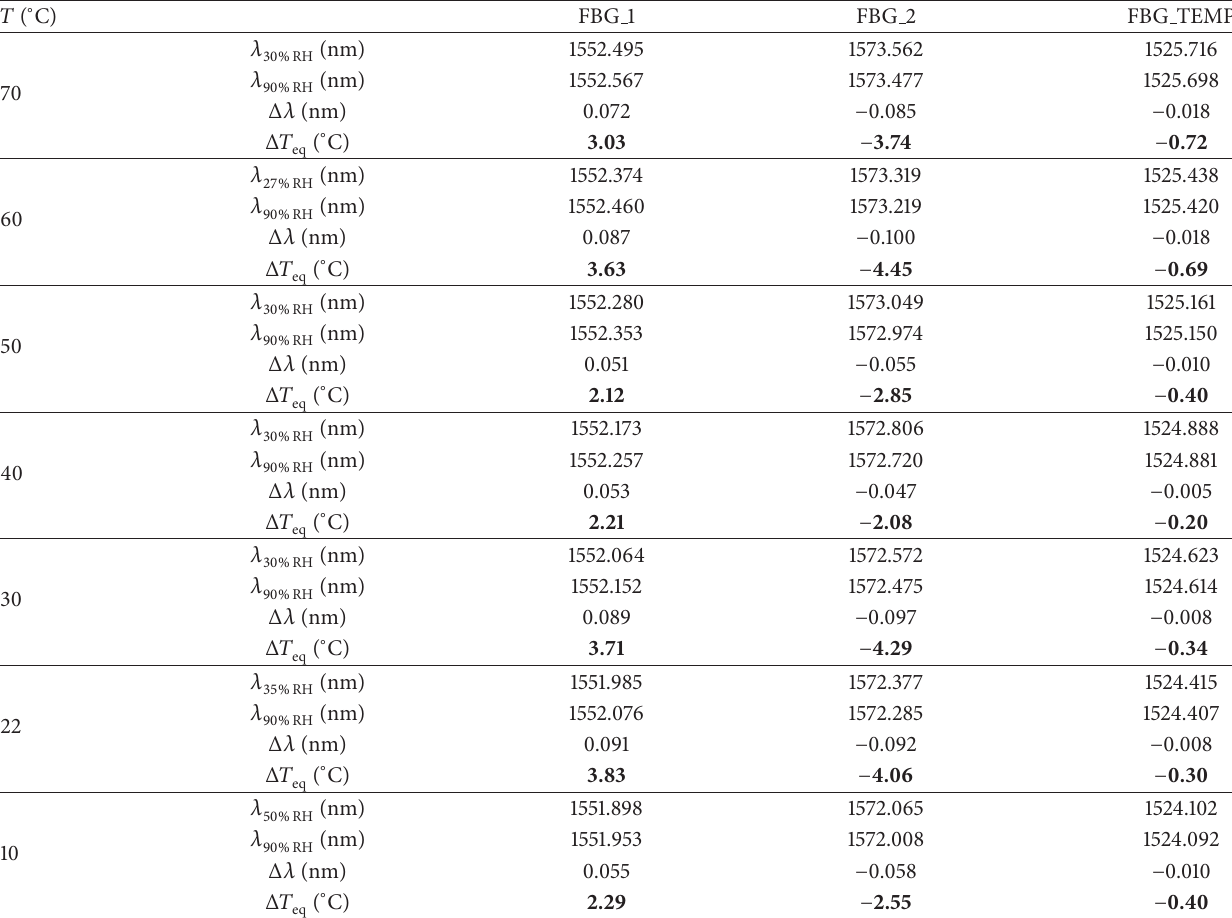
Table 2: Bragg wavelength shifts and equivalent temperature variation obtained at different measurement conditions for each FBG